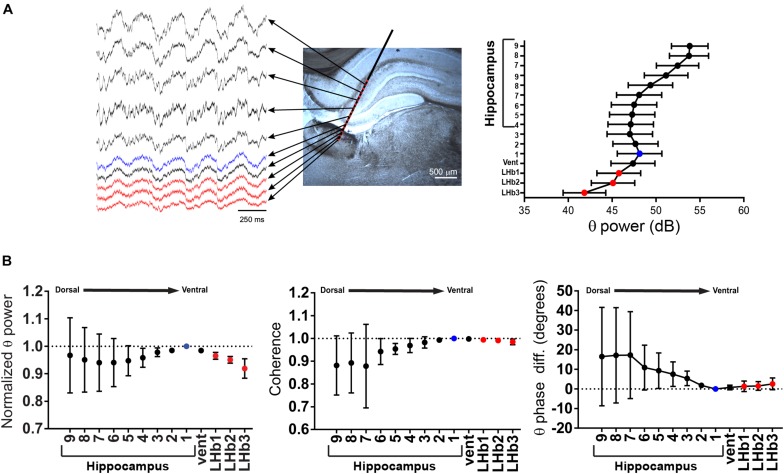
(A) Left, schematic representation of an experiment with a silicon probe. Traces are representative recordings during theta from electrodes located at the lateral habenula (LHb) (red dots), from the ventral hippocampal electrode taken as reference (light blue dot, see below), and from the other electrodes (black dots). For clarity, only half of the hippocampal electrodes are displayed. Right, power in the theta band could be readily detected at all recording sites. Data are taken from experiment 2 shank 1 (see Supplementary Figure S1) and presented as mean ± confidence interval. (B) Summary of data from four shanks from two experiments. Theta power, coherence, and phase were referred to the recording site with the highest power within the ventral part of the hippocampus (light blue dot). Theta power decreased linearly from the reference recording site onto the LHb (red dots). Coherence was high in all LHb recording sites, and phase difference was small. In contrast, coherence decreased in the dorsal hippocampal recording sites, along with a clear phase shift (vent: presumably ventricle located recording site).